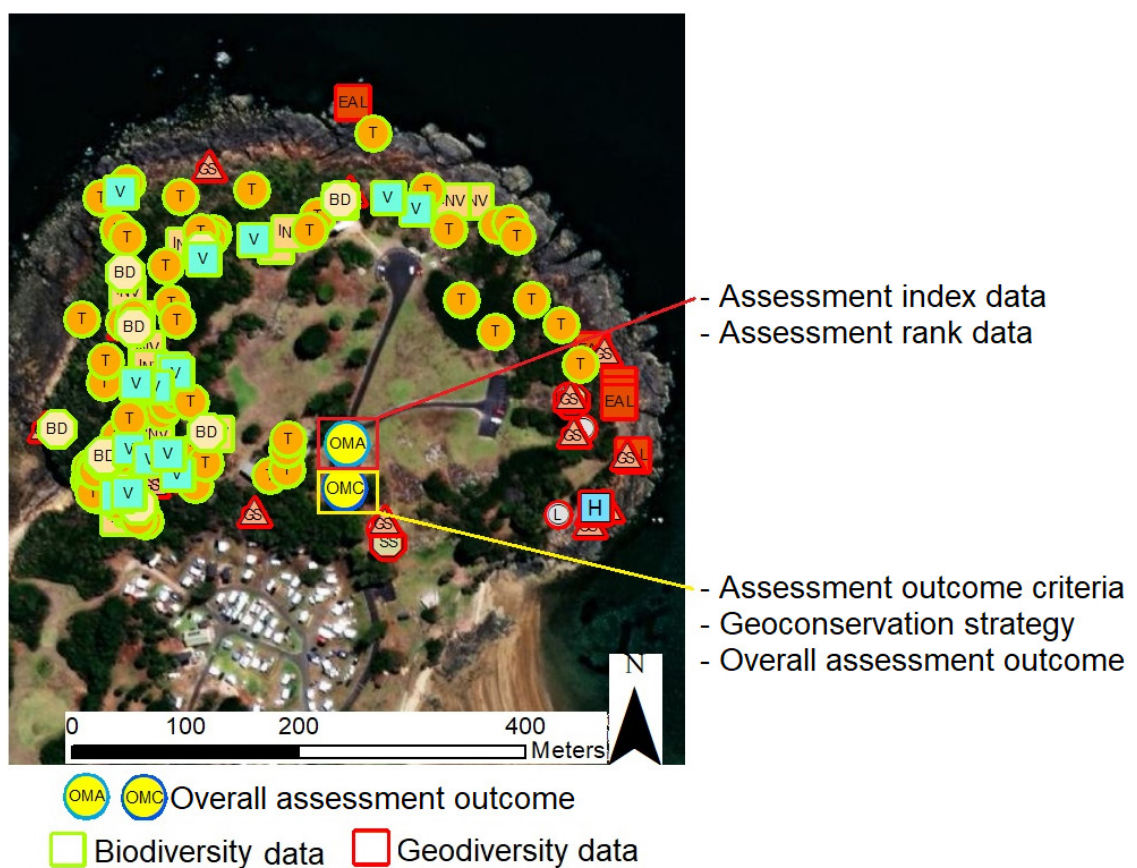
Figure 5. Example of all data captured from ArcGIS Survey123 and FieldMaps compiled into one map at Mersey Bluff Pseu- do-Petroglyphs geoconservation site, uploaded to ArcGIS Online, with geodiversity, biodiversity and consolidation approach included (© ESRI background aerial imagery).